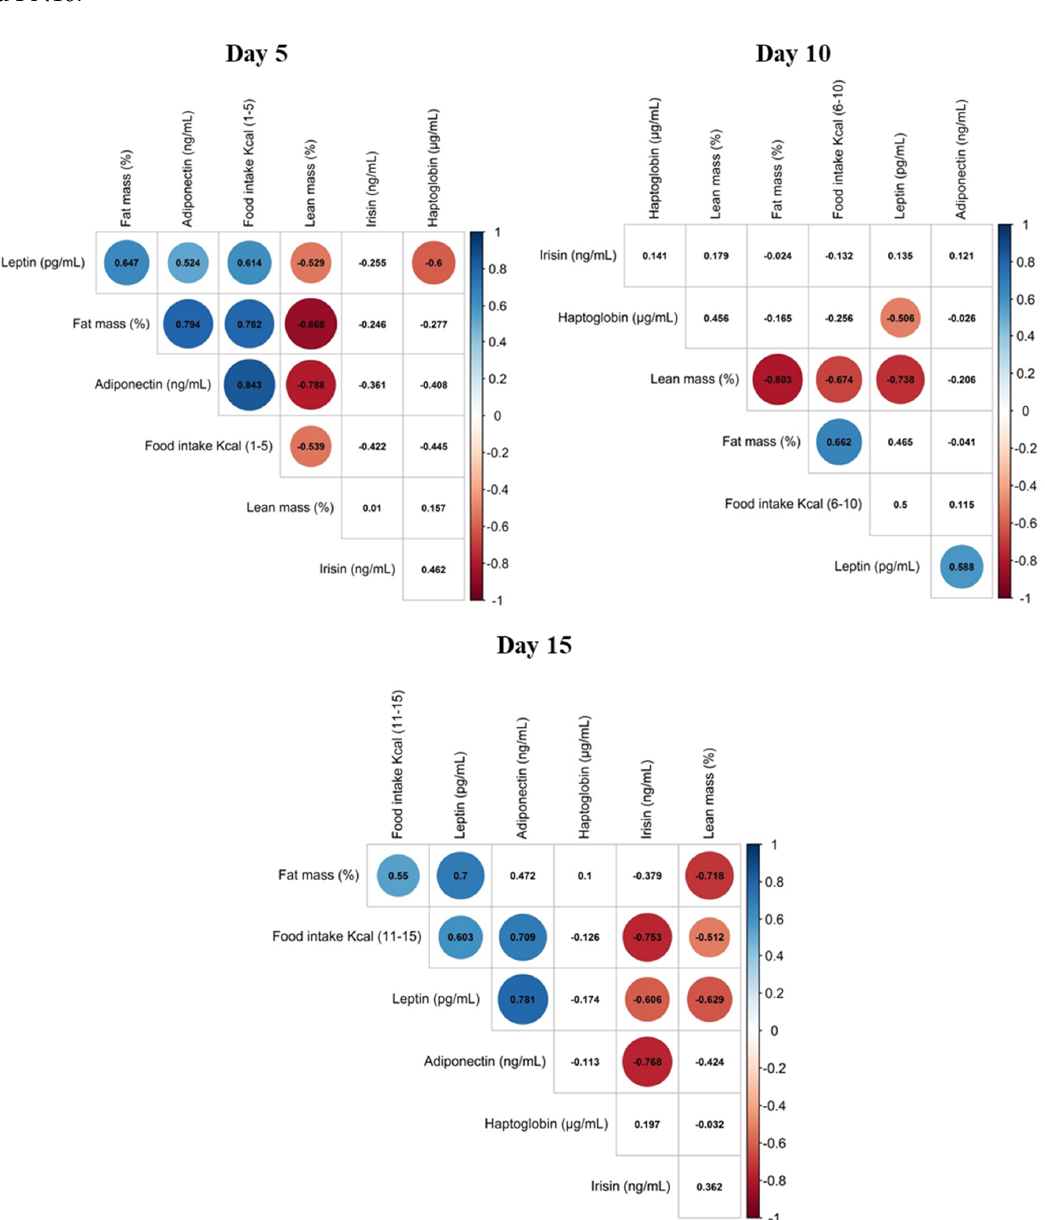
Figure 4. Correlations within maternal food intake, body fat content and lean mass, and leptin, adiponectin, irisin and haptoglobin concentration in milk on days 5, 10 and 15 of lactation of control (C-dams) and cafeteria diet-fed dams (CAF-dams). The comparison was done by non-parametric Rho Spearman correlation. The representation of the correlation matrixes of the Rho values are presented as clusterized heatmaps, in which significant Rho values are replaced by a colored cycle according to the strength of the dependence.